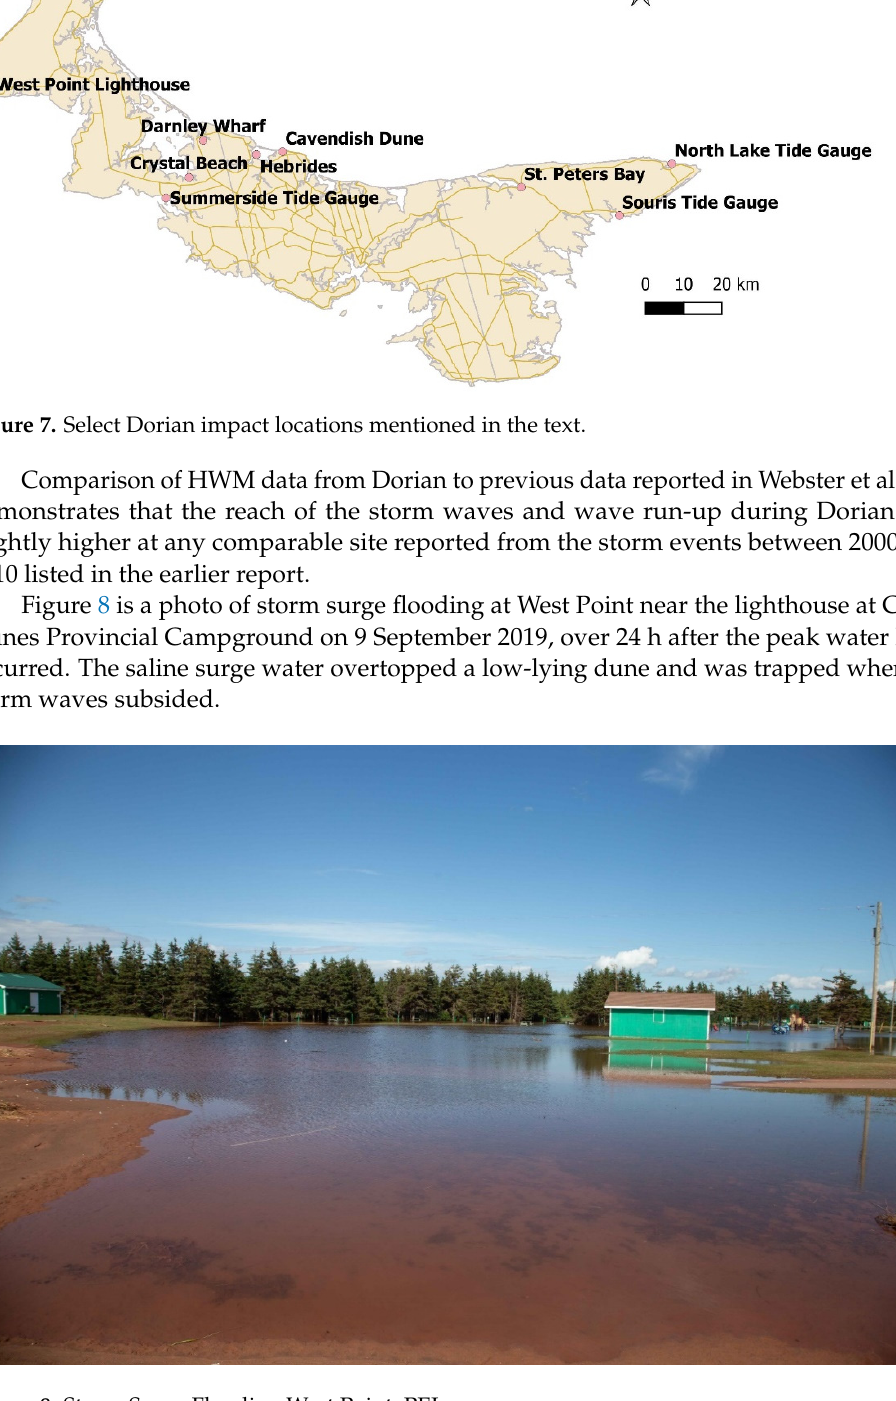
Figure 8. Storm Surge Flooding West Point, PEI.